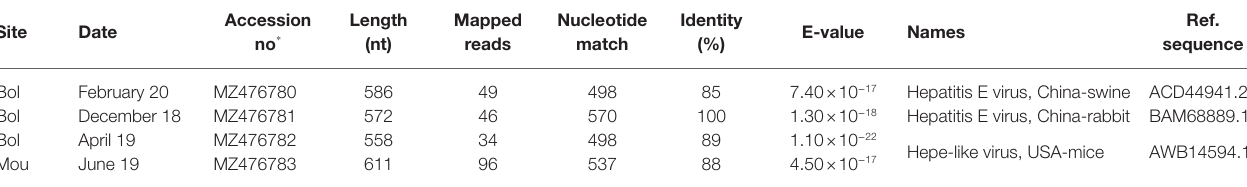
TABLE 7 | Hepeviridae sequences identified in Sanaga